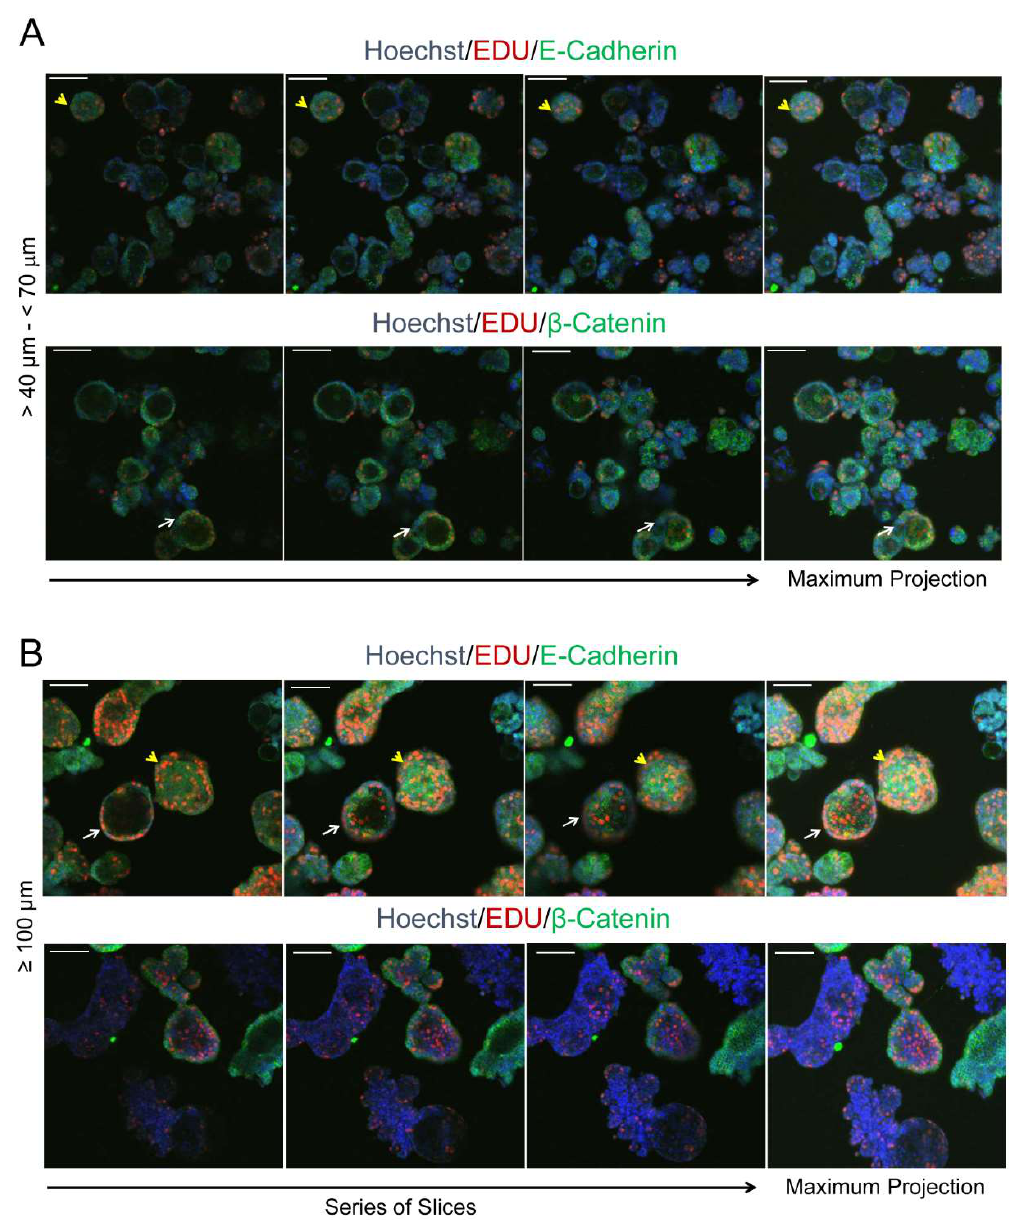
Figure 9. Multicellular structures isolated from peritoneal effusions as evaluated by inverted confocal microscopy. In ( A , B ) yellow arrowheads denote compact multicellular structures; white arrows show hollow multicellular structures. EdU labelling in red denotes cells synthesizing DNA. Green staining denotes expression of E-cadherin and β-catenin. Blue, Hoechst staining. Scale bars = 100 μm.